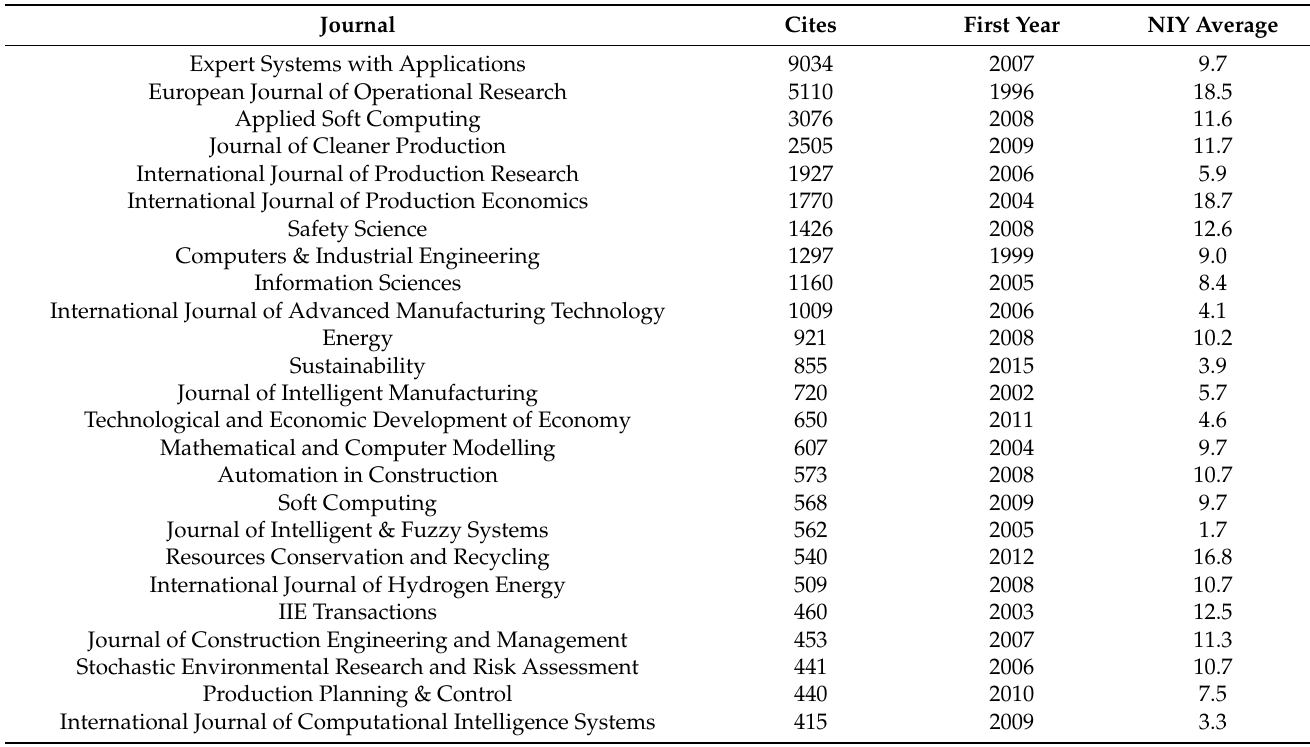
Table 4. Top 25 Journals by